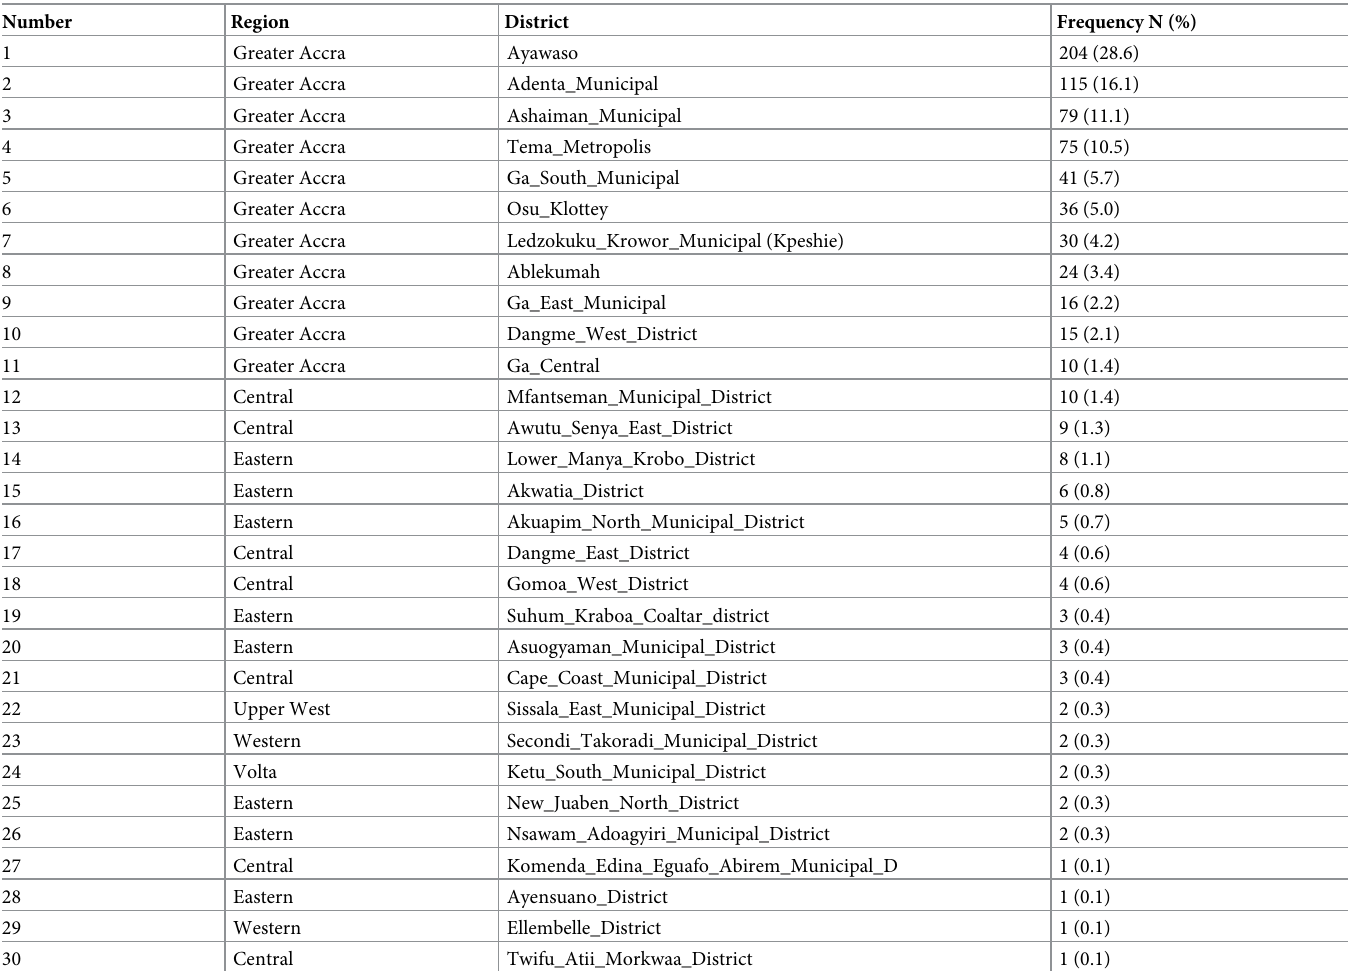
Table 1. Geographical location of study